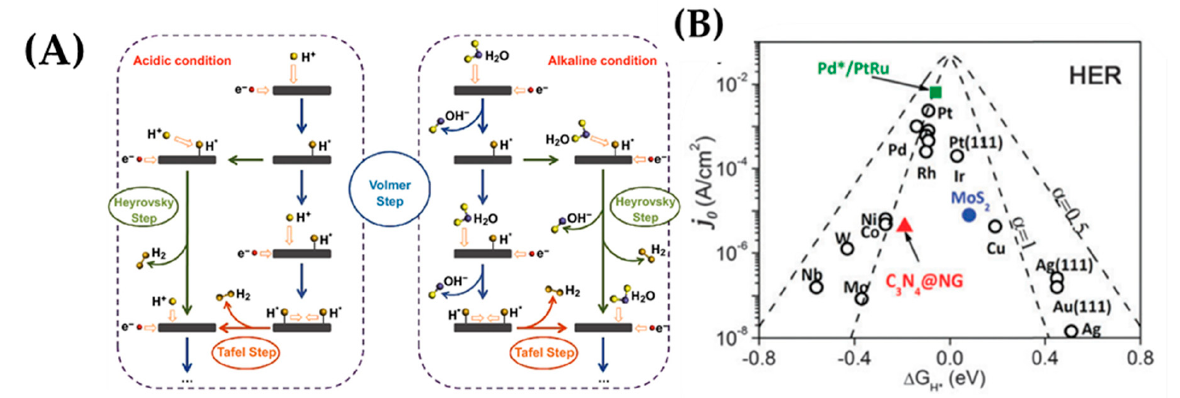
Figure 26. ( A ) Schematic representation of HER pathways in acidic and alkaline solutions, adapted with permission from [129]; ( B ) Volcano plot for HER j 0 vs. hydrogen adsorption free energy for various metals, alloys, and non-metallic materials. Adapted from [115] with permission.